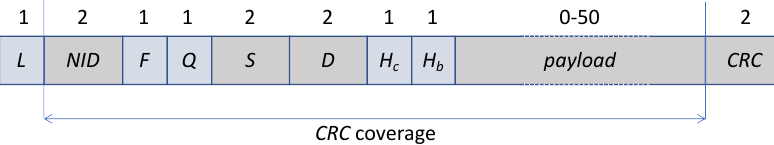
Figure 5. Base packet format in unsecured